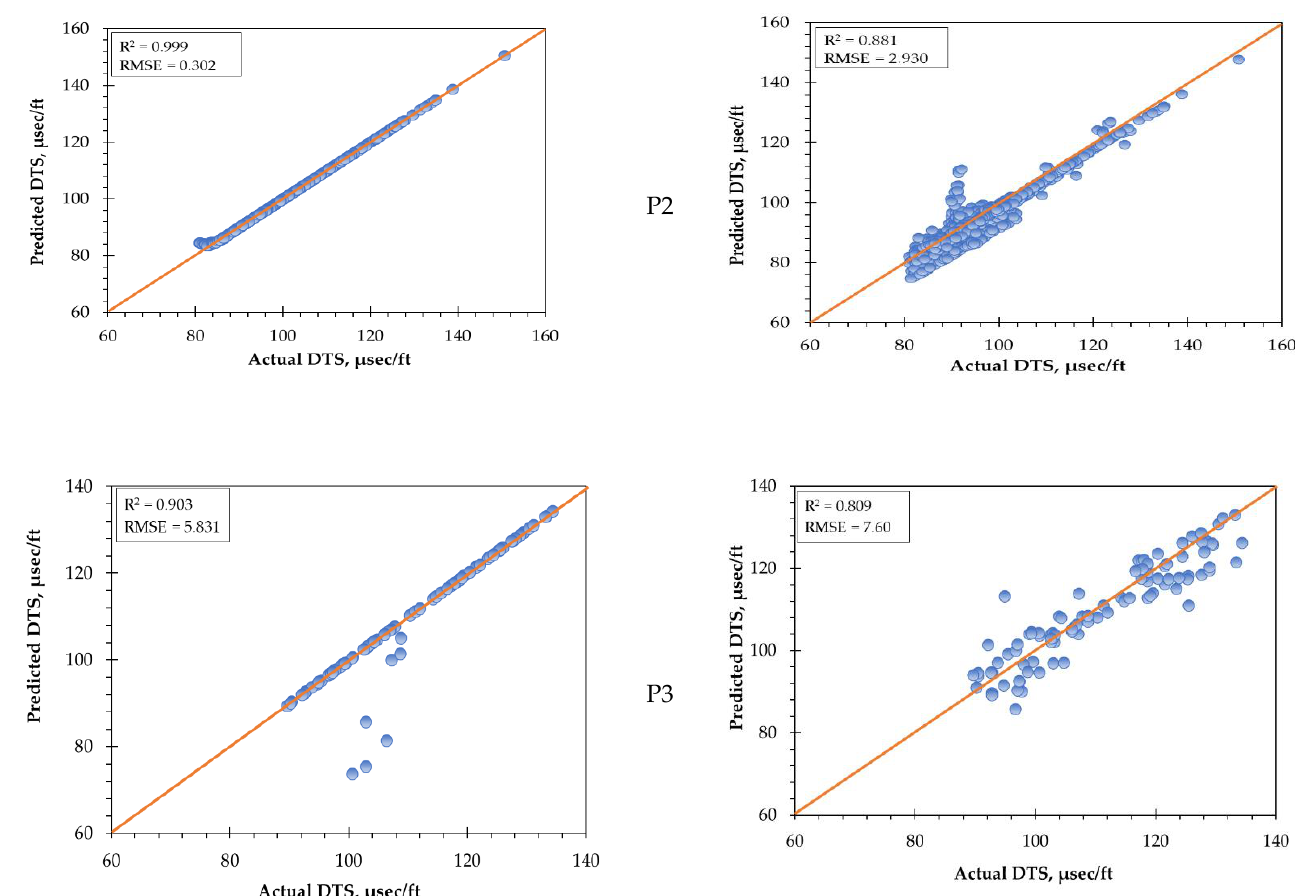
Figure 12. Actual vs. predicted DTS value from single well prediction using RF and Bi-LSTM model.